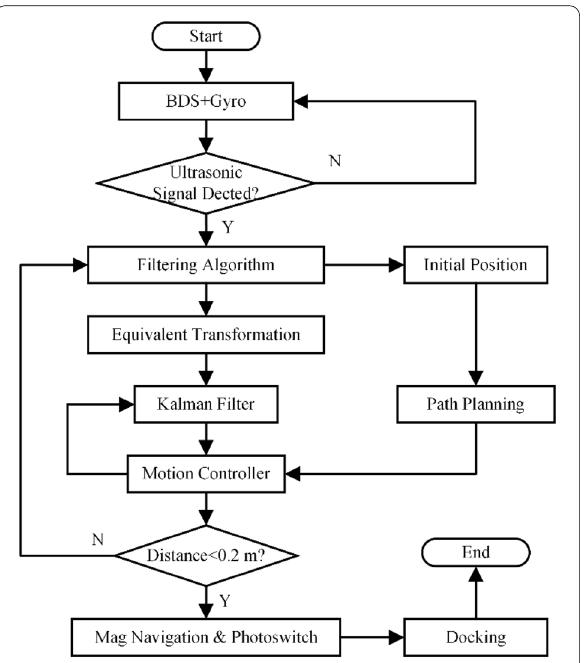
Figure 16 Flow chart of the proposed navigation control system